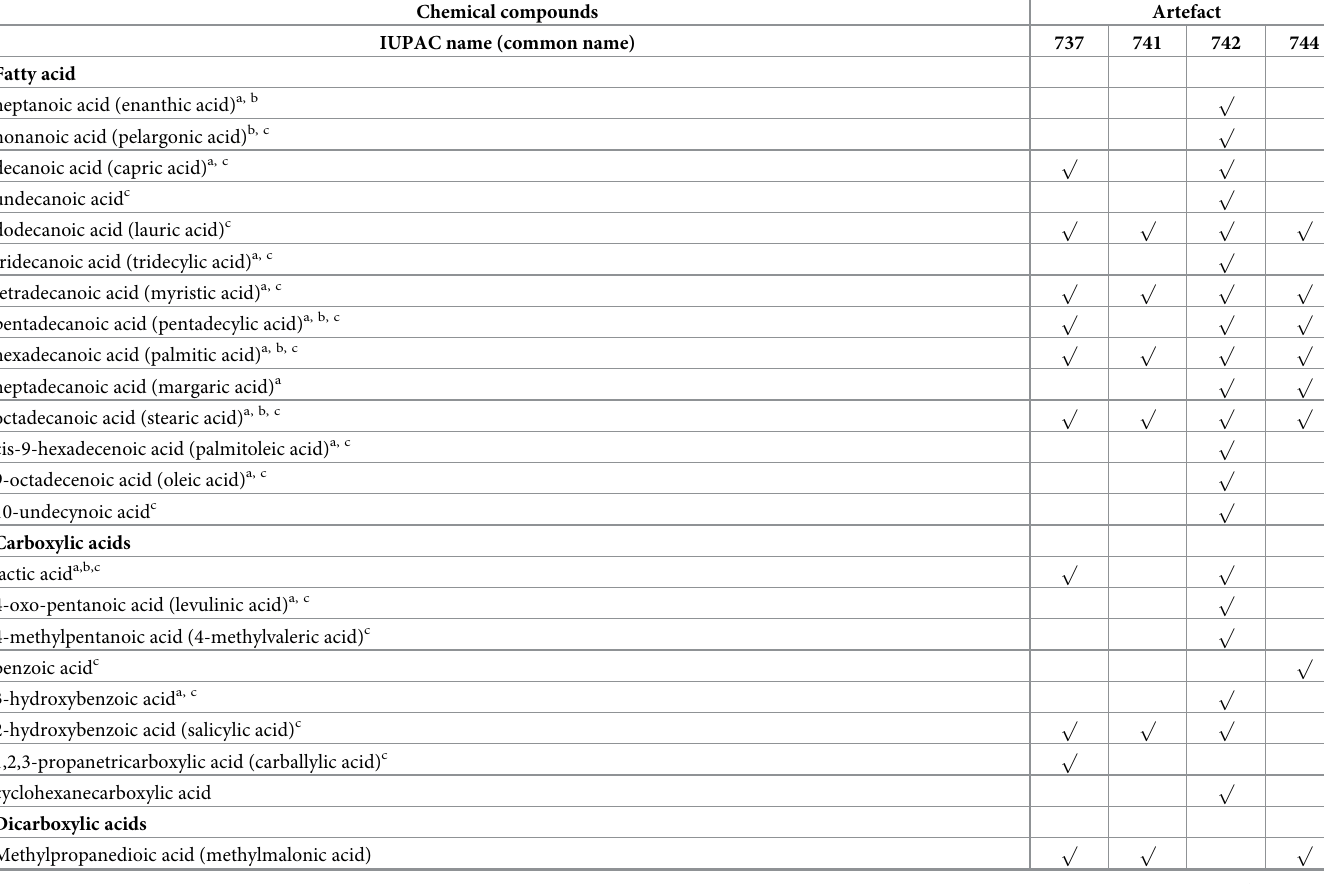
Table 5. The compounds identified in the residue from the sphero-conical vessels using GC-MS. Chemical